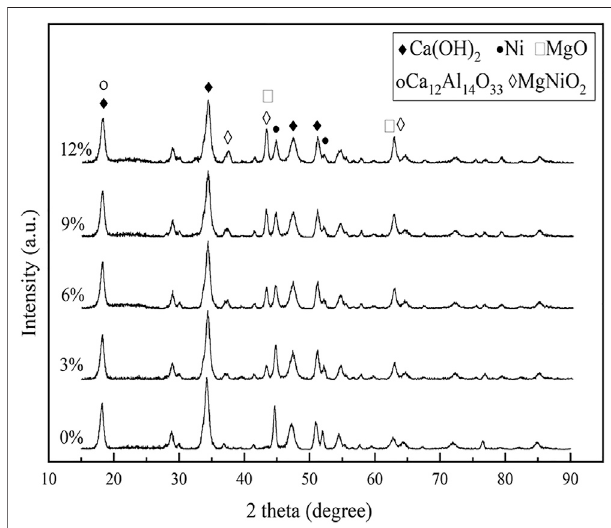
Frontiers in Energy Research |